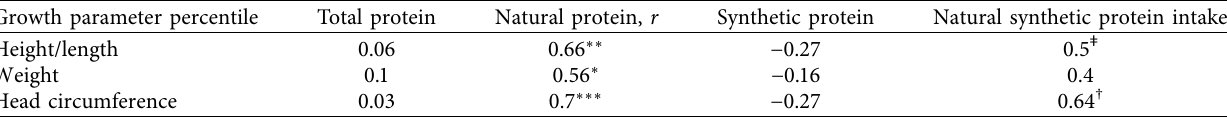
Table 4: Correlation between the different growth percentiles and protein